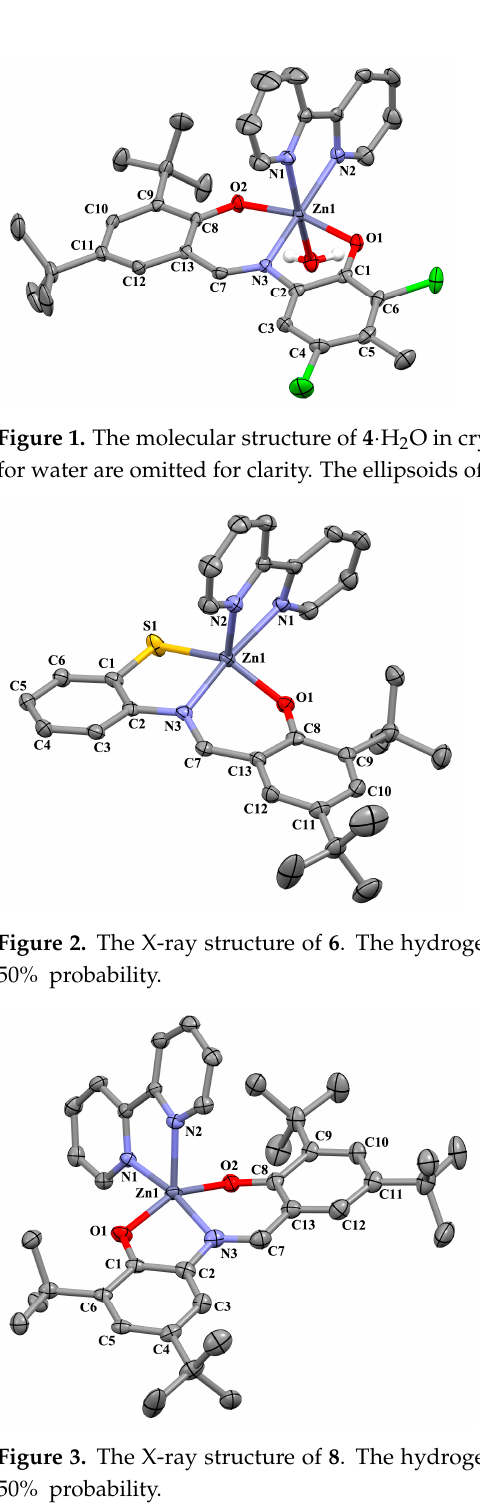
Figure 3. The X-ray structure of 8 . The hydrogen atoms are omitted for clarity. The ellipsoids of 50% 50% probability.